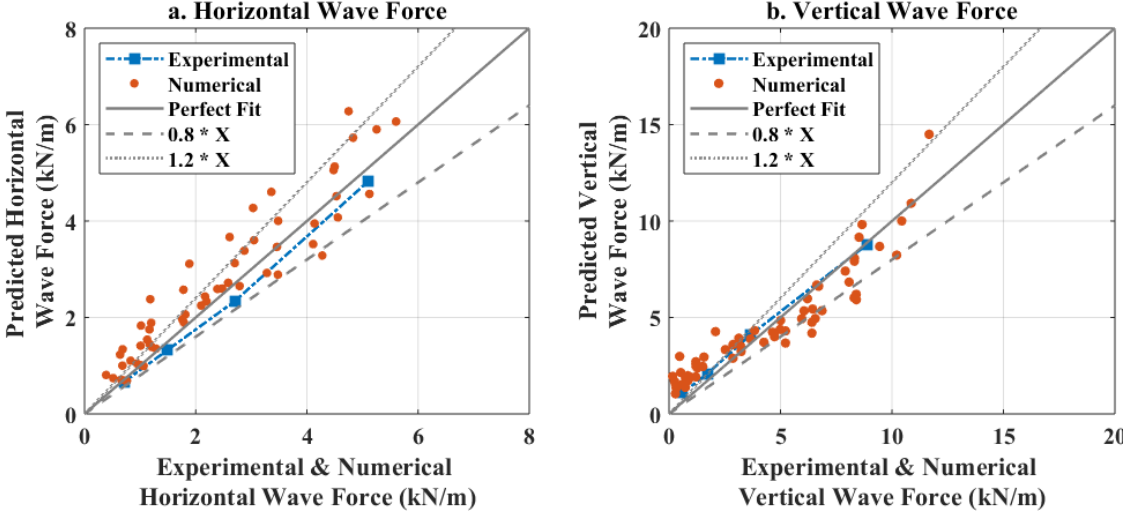
Figure 22. Comparisons of the maximum wave forces predicted by the new method with the numerical results and experimental measurements.